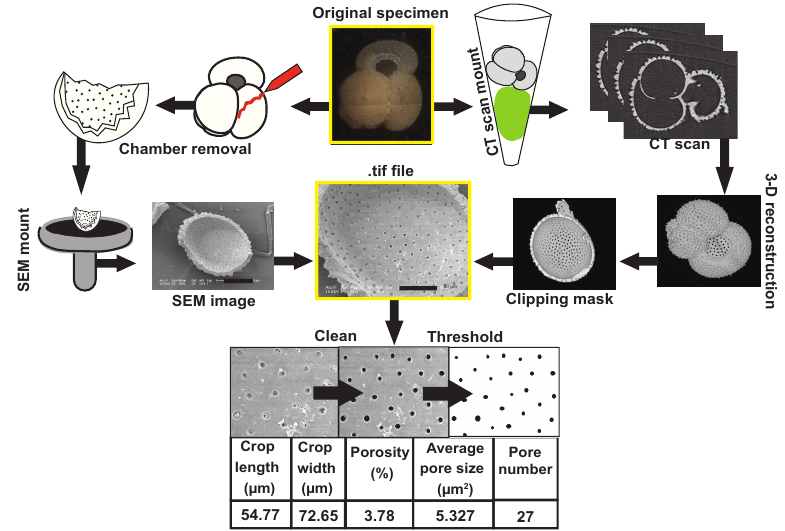
Figure 2. Workflow diagrams for porosity and CT scan analyses. Pore characteristics for this study were measured on the internal test wall from SEM images of dissected foraminifera (pathway illustrated on the left side) or from CT scans (as shown on the right side). The method for extracting volume and surface area measurements is also shown on the far